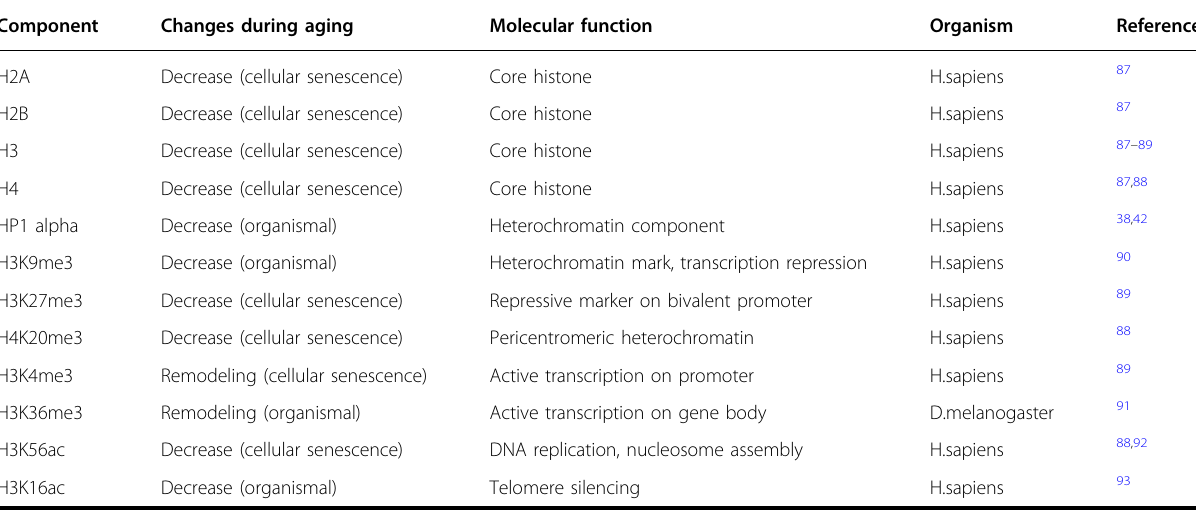
Table 1 Major chromatin marker changes during